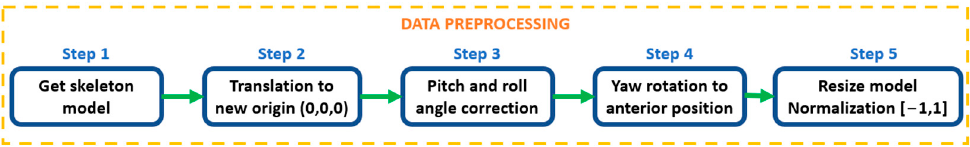
Figure 3. Proposed five steps for image preprocessing.